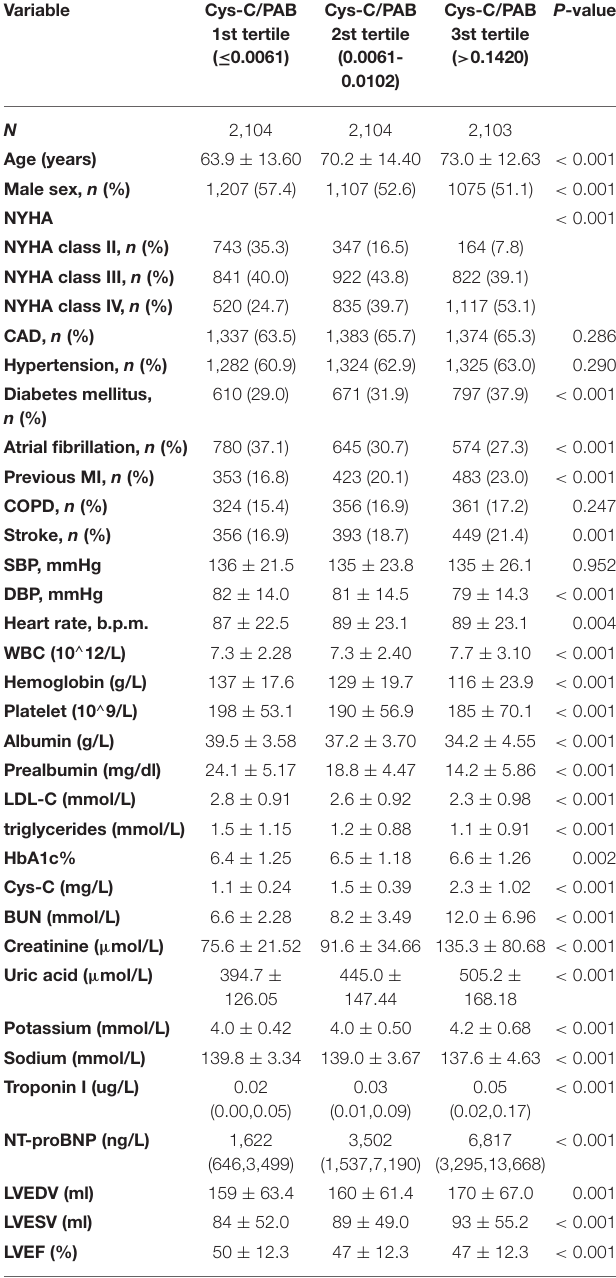
TABLE 1 | Baseline clinical characteristics, median (IQR), or N (%), or means ± SD. Variable